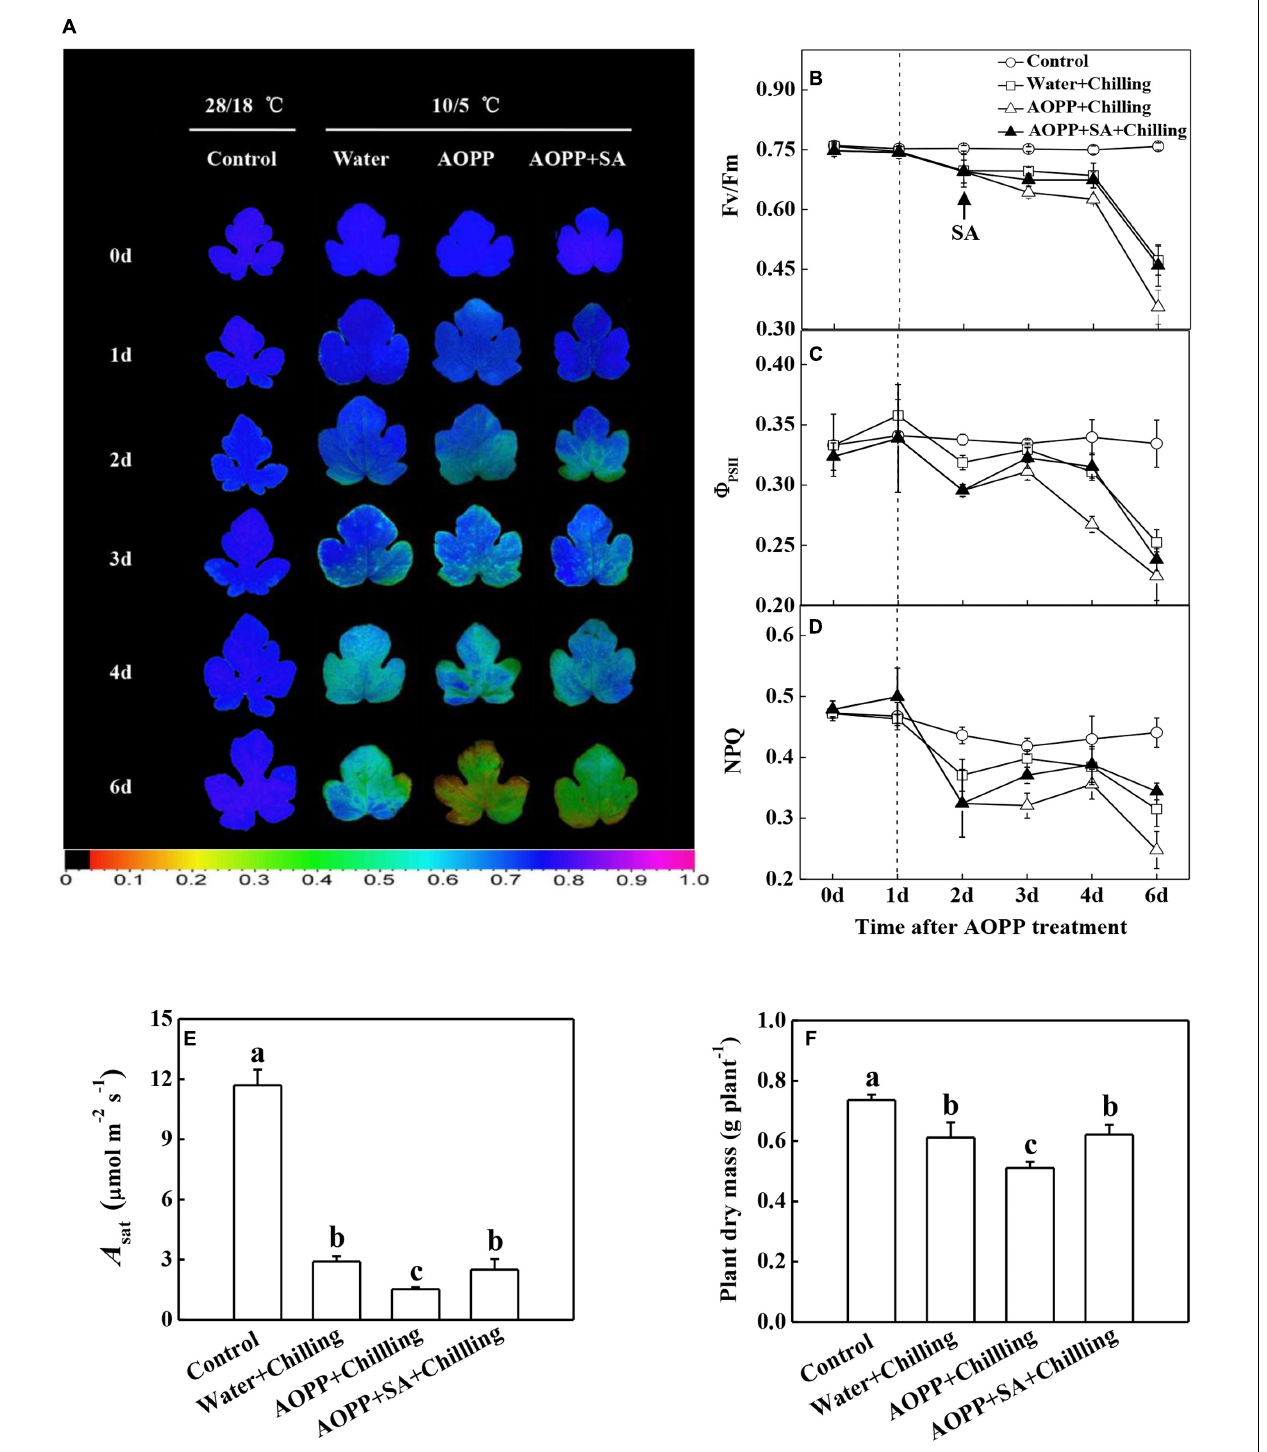
FIGURE 4 | Effects of chilling and SA on the photosynthetic capacity and growth in watermelon plants. (A) Images of F v/ F m. (B) F v/ F m values. (C) (cid:56) PSII values. (D) NPQ values. (E) Light-saturated rate of CO 2 assimilation ( A sat ). (F) Plant dry mass. The vertical dashed line in (B–D) indicates the transfer of the plants from 28/18 ◦ C to 10/5 ◦ C. Leaf samples were collected at the indicated times for chlorophyll fluorescence analysis. A sat and plant dry mass were measured at 5 days after chilling treatment. The data are the means of four replicates with SEs. Different letters indicate significant differences between the treatments according to Tukey’s test ( P <